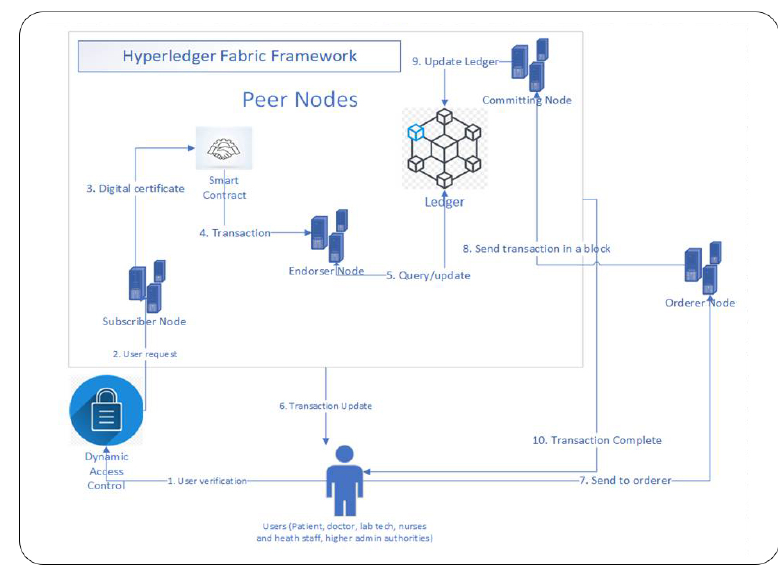
Figure 4. The framework designed using Hyperledger